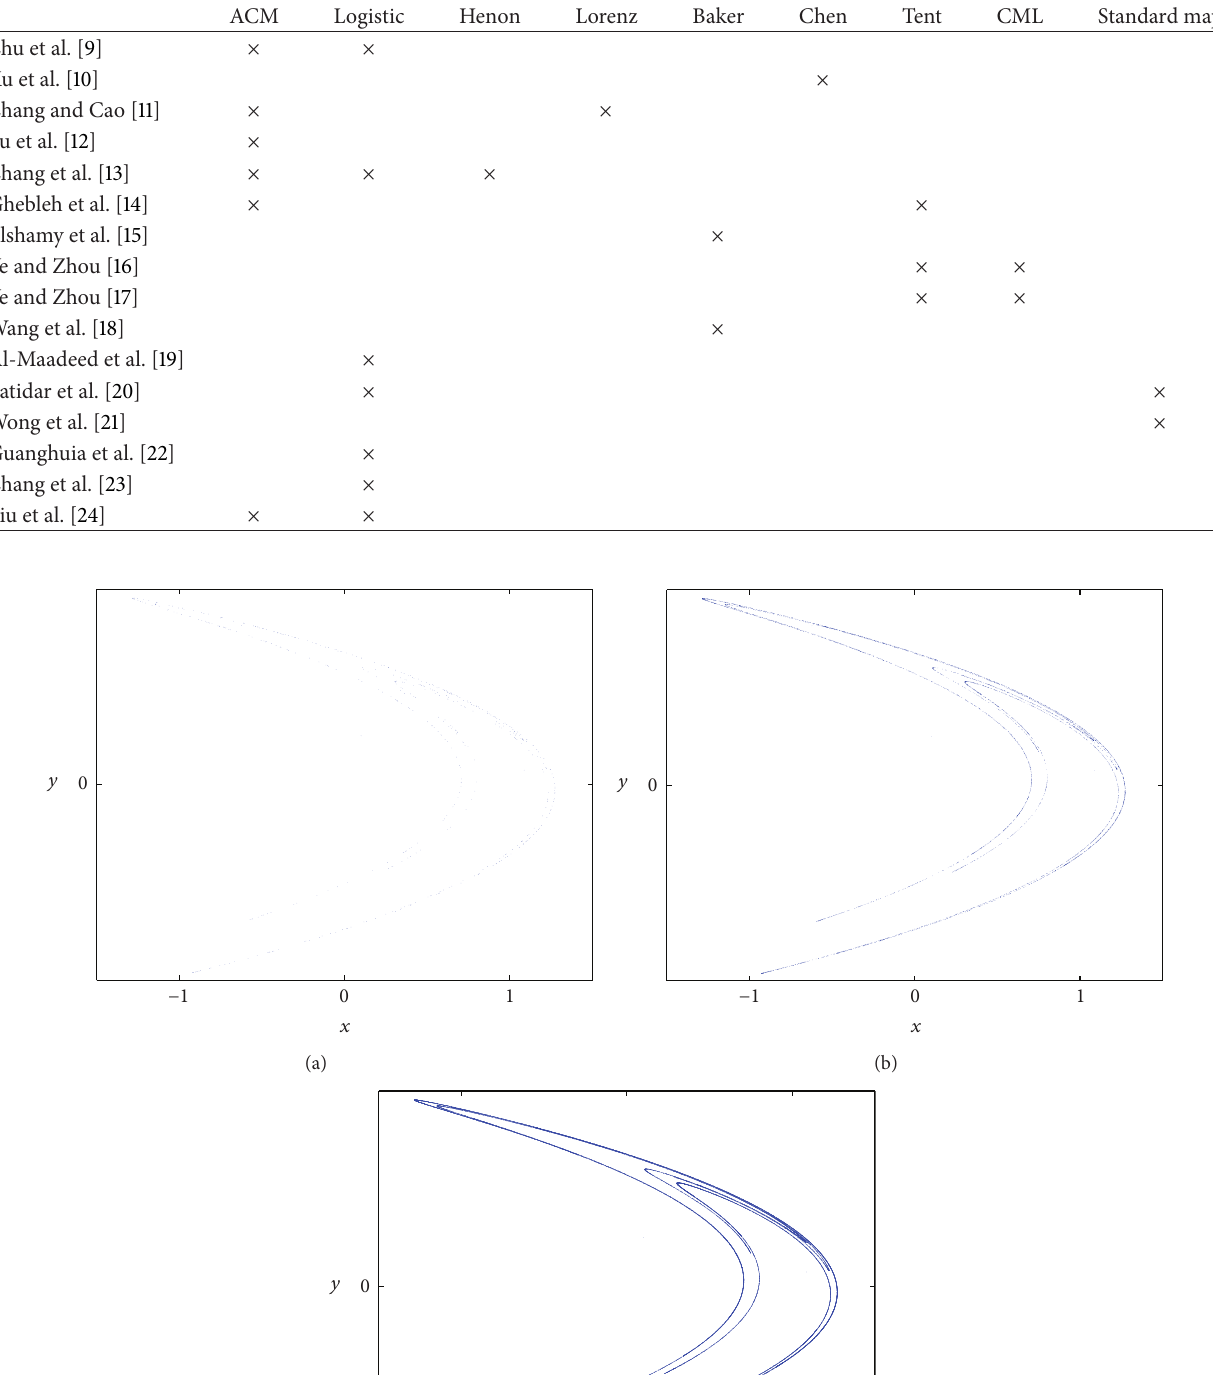
Table 1: Applied chaos maps in some proposed image encryption techniques.